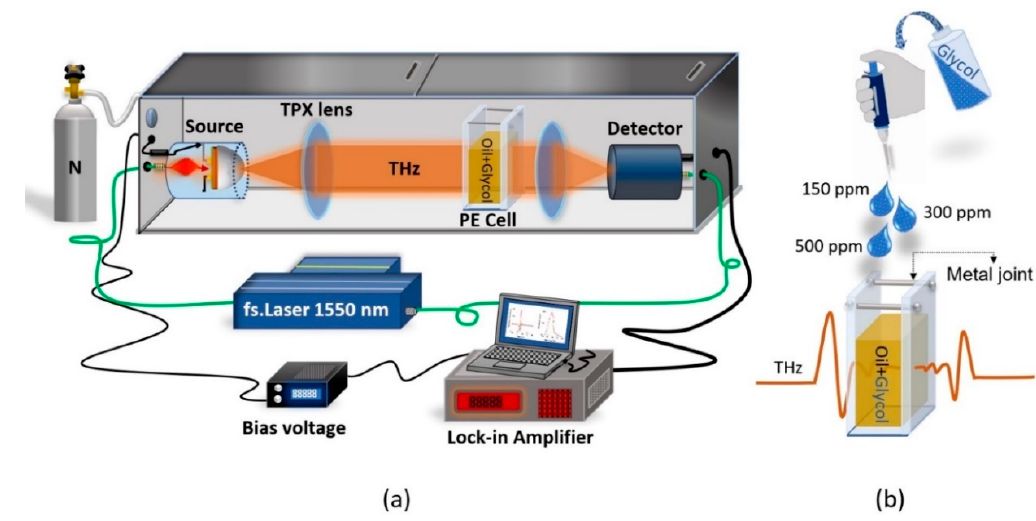
Figure 1. Illustration of ( a ) THz time-domain spectrometer and ( b ) THz path through the contaminated oil samples. The glycol-contaminated samples were shaken prior to THz measurements in order to obtain a homogeneous mixture.